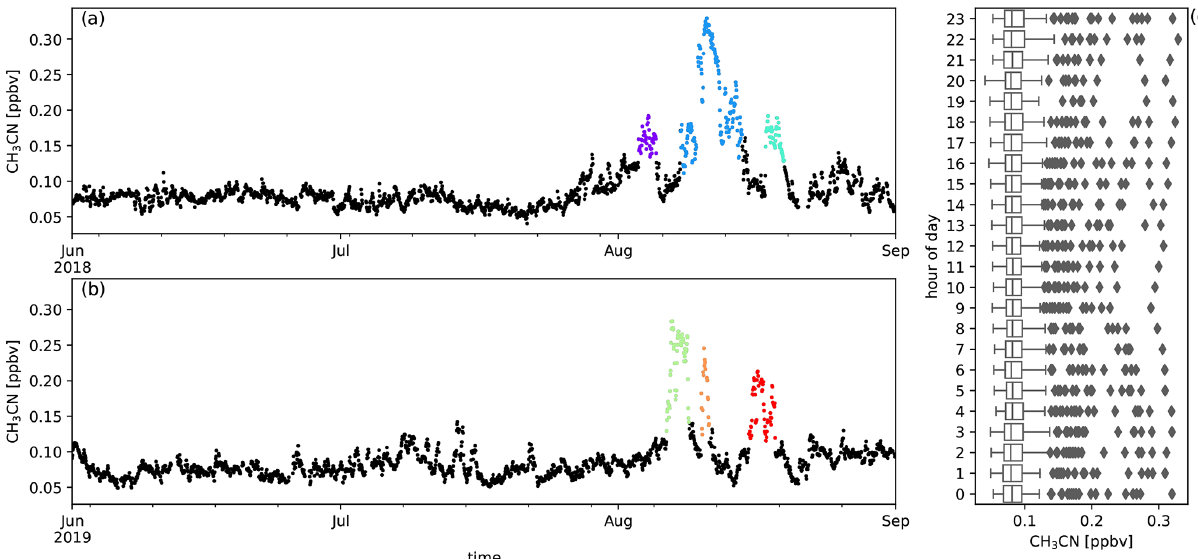
Figure A3. Measured CH 3 CN mixing ratios (ppbv) during austral winter 2018 (a) and austral winter 2019 (b) together with the diel distri- bution of hourly averages (c) . Biomass burning plumes under investigation are highlighted in